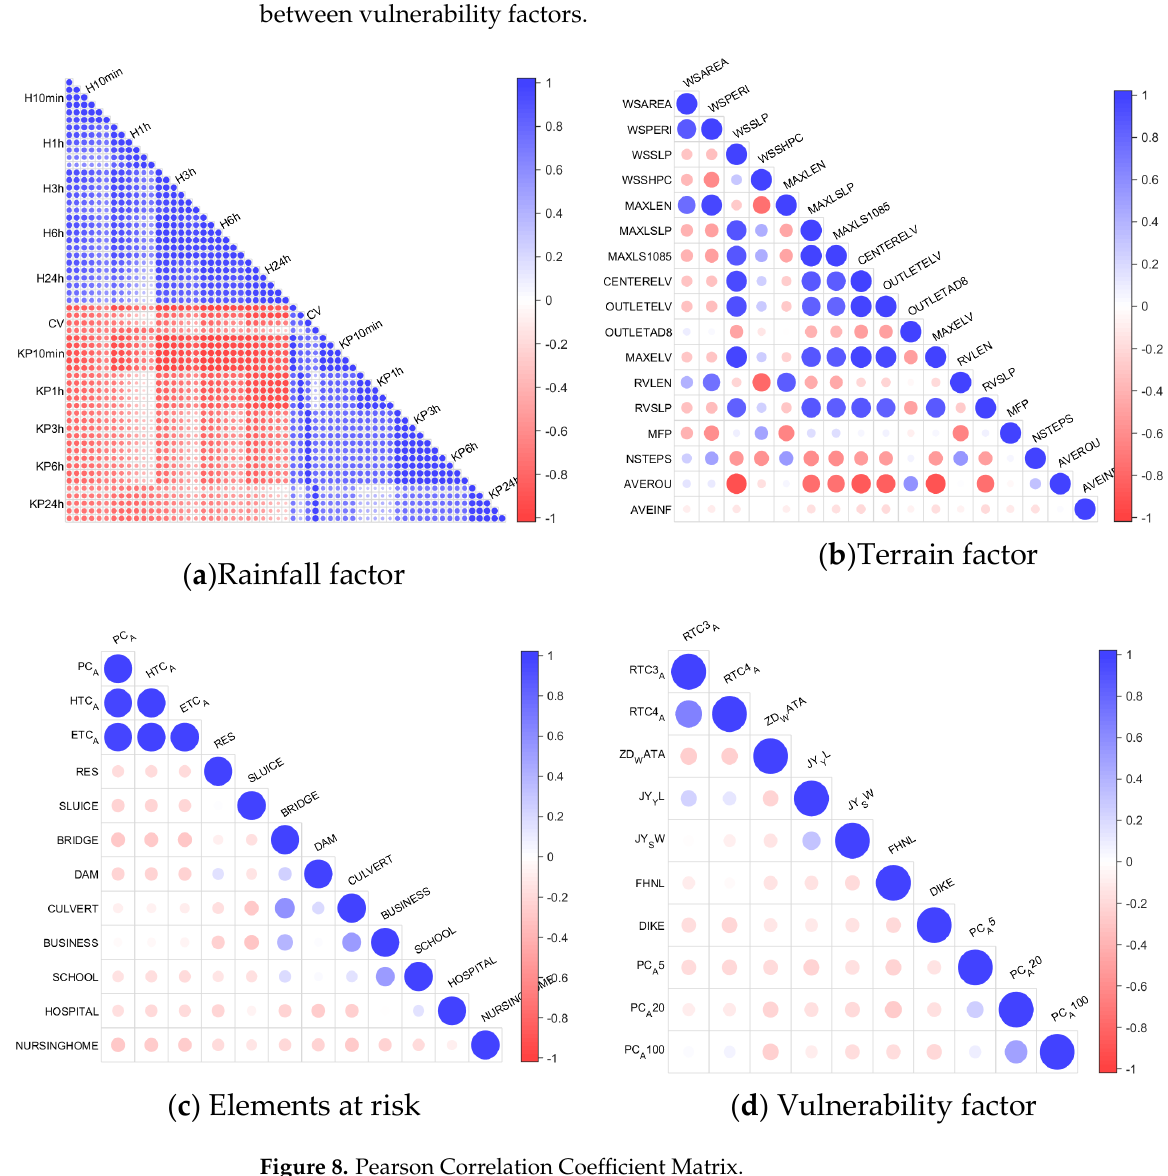
Table 5. Cumulative Contribution of Principal Components.